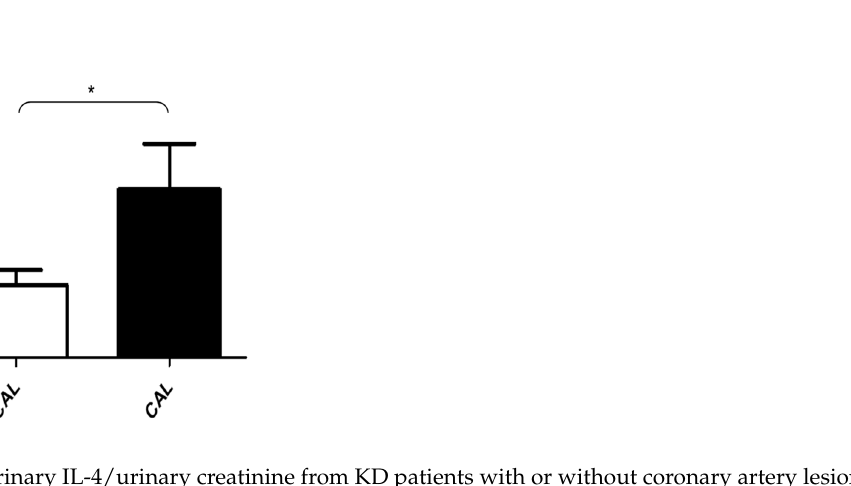
Figure 2. Changes in urine cytokines corrected to urine creatinine: ( A ) interleukin (IL)-1 β , ( B ) IL-6, ( C ) IL-8, ( D ) IL-13, ( E ) interferon-gamma-induced protein (IP)-10, and ( F ) monocyte chemoattractant protein (MCP)-1 from patients with Kawasaki disease before (pre) and three days after (post) intravenous immunoglobulin (IVIG) treatment, tested by Wilcoxon matched pairs test. * for p < 0.05, ** for p < 0.01 and *** for p < 0.001.